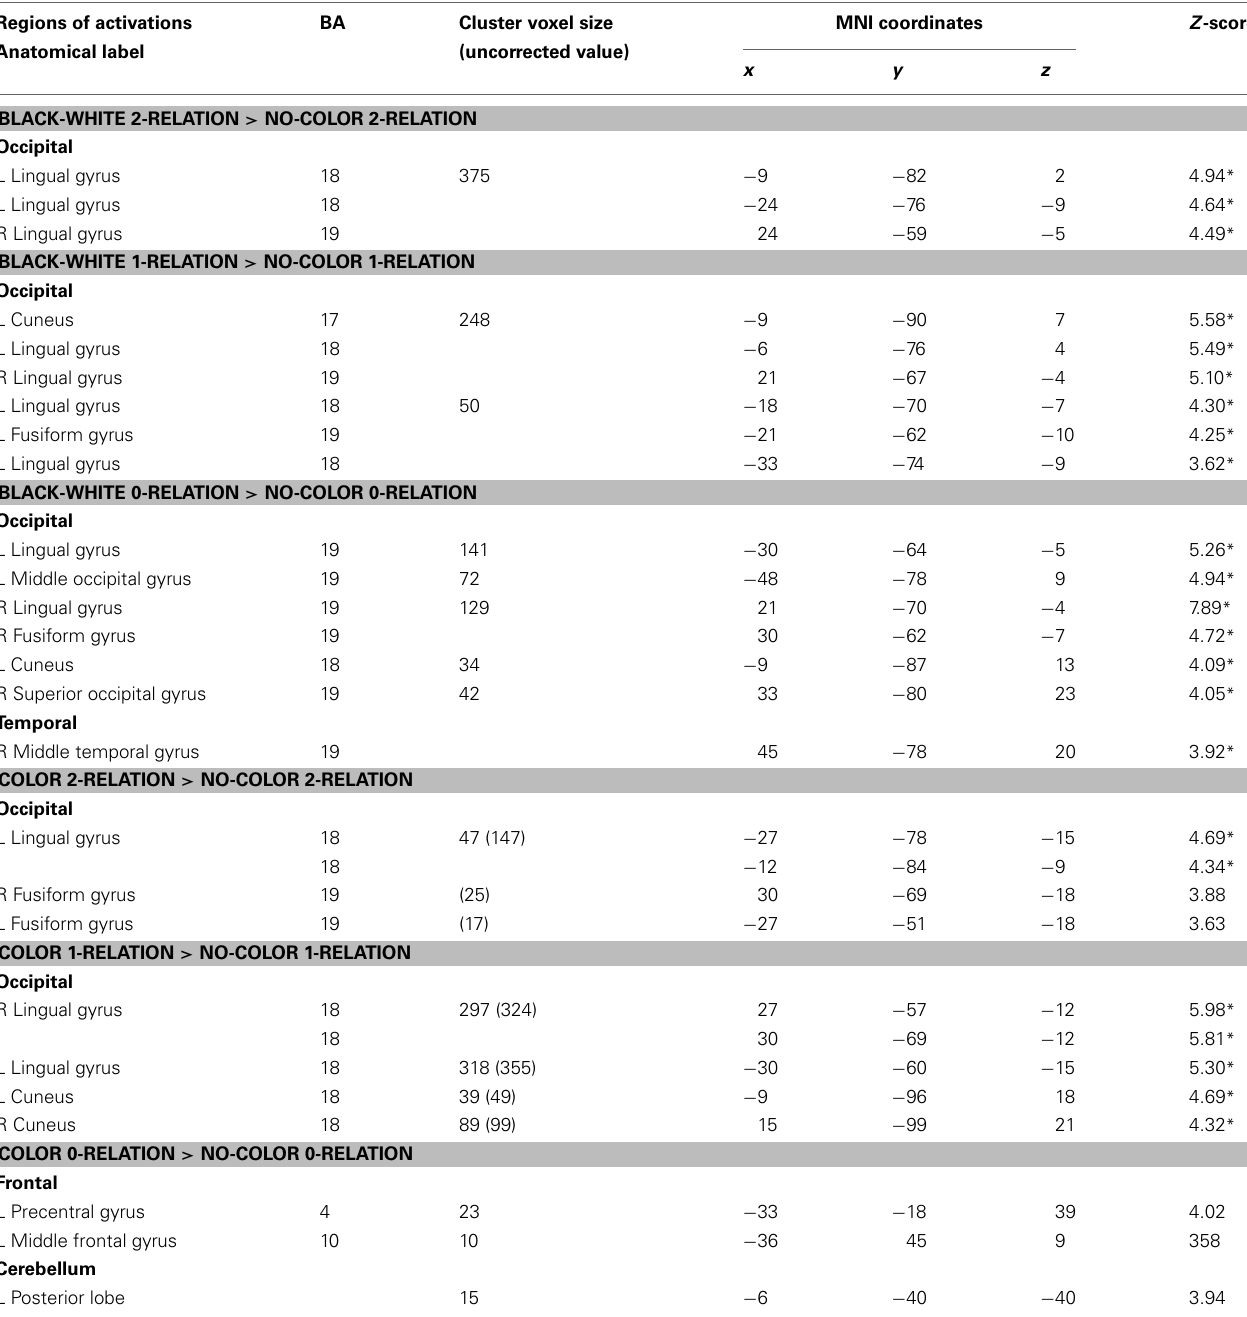
Table 2 | Sensory contributions to reasoning—neuroanatomical results for random-effects analysis between BWVC, Color, and NC conditions at 0, 1, 2